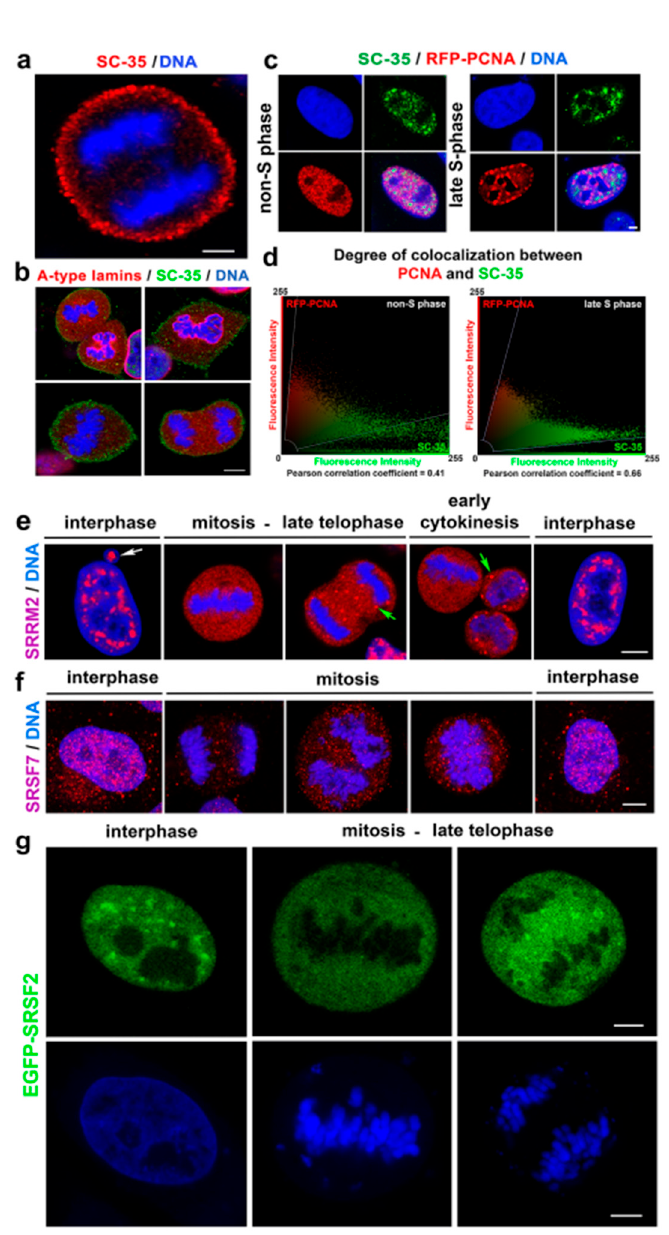
Figure 8. Nuclear localization of the following proteins: SC-35, PCNA, SRRM2, and SRSF7. ( a ) The SC-35 protein accumulated in tiny foci, localized in proximity to the plasma membrane. A high density of EGFP-SRSF2 was found in the cytoplasm of the cells in telophase. The analysis was performed in HeLa cells. Scale bar shows 7 μ m. ( b ) No colocalization was observed between SC-35 and A-type lamins in mitotic HeLa cells. Scale bar shows 10 μ m. ( c ) A link of SC-35 (green) to RFP-tagged PCNA (red) in both non-S phase cells and the cells in the late S-phase of the cell cycle. ( d ) Pearson’s correlation coefficient for SC-35 and PCNA was 0.41 in non-S cells, and this coefficient was higher (0.66) in the cells in the late S-phase; see an example in this panel showing analysis of cells in panel c . Localization of ( e ) SRRM2 and ( f ) SRSF7 proteins in the interphase, mitosis-late telophase, and early cytokinesis. The white arrow shows nuclear bleb, and the green arrows show SRRM2-positive foci in the cytoplasm of late telophase and at the early cytokinesis stage. ( g ) Distribution profile of GFP-tagged SRSF2 in interphase and mitotic HeLa cells. Scale bar shows 5 μ m.